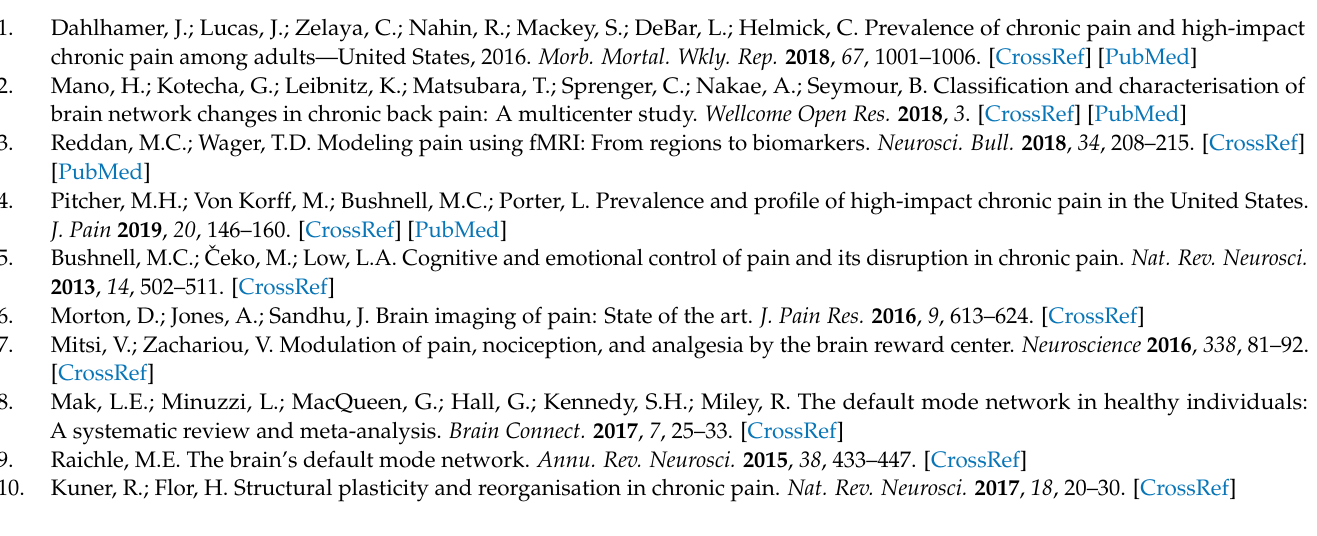
A basic timeline of the entire study, Table S1: List of behavioral and neuropsychological assessments, Table S2: List of all x , y , z coordinates for the nodes involved in each of the four networks, Table S3: List of the nodes presented in Figure 2A,B,C, Table S4: List of significant edges of the salience network involving four nodes, Table S5: List of the significant edges of triple network (t > 3.4), Table S6: List of significant edges of the triple network (t > 2.1), Table S7: Statistically significant changes scores of behavioral assessments administered, Table S8: Correlations between significant assessment and edge